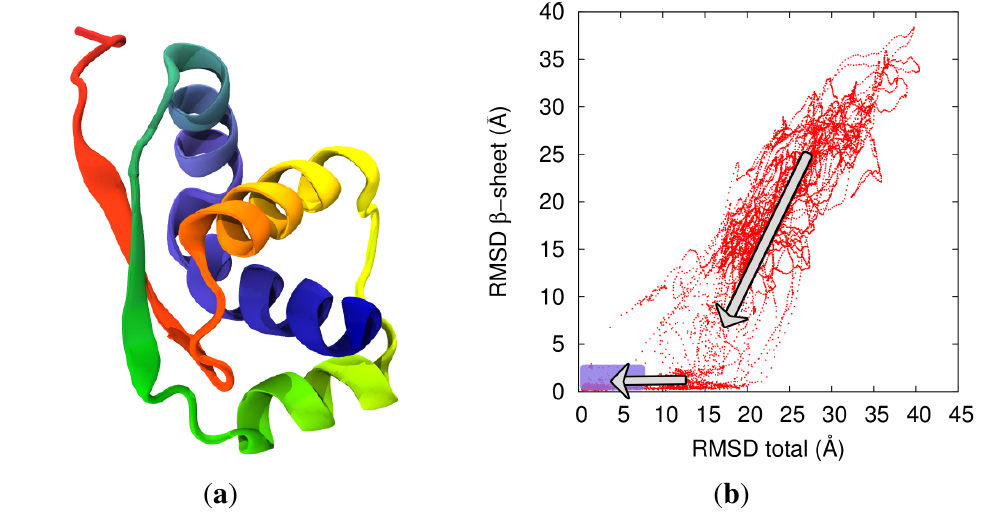
Figure 4. ( a ) Cartoon of the native conformation of MJ0366 (PDB entry: 2efv). The β -sheet locks the loop that is threaded by the C -terminus in the native fold, thus producing a trefoil knot. ( b ) Atomistic DRP folding trajectories projected on the plane defined by the RMSD relative to the native coordinates of the non-local β -sheet and the RMSD relative to the native coordinates of the total structure. Arrows indicate the directionality of the folding trajectories. It is noticed that the β -sheet has to be well-formed before the trajectories proceed to the native knotted state. The purple overlayed rectangle highlights the region encompassing all first knotting events. Adapted with permission from